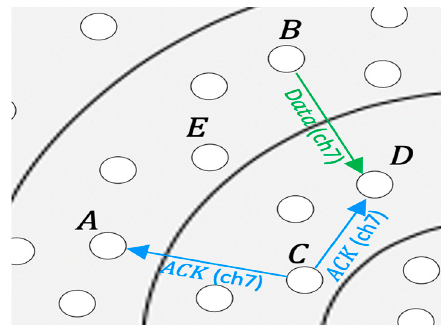
Figure 22. Data collision example.